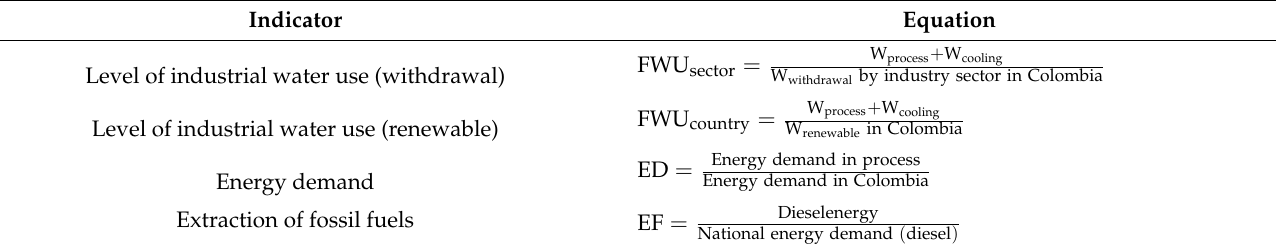
Table 12. Social indicators used to evaluate the social